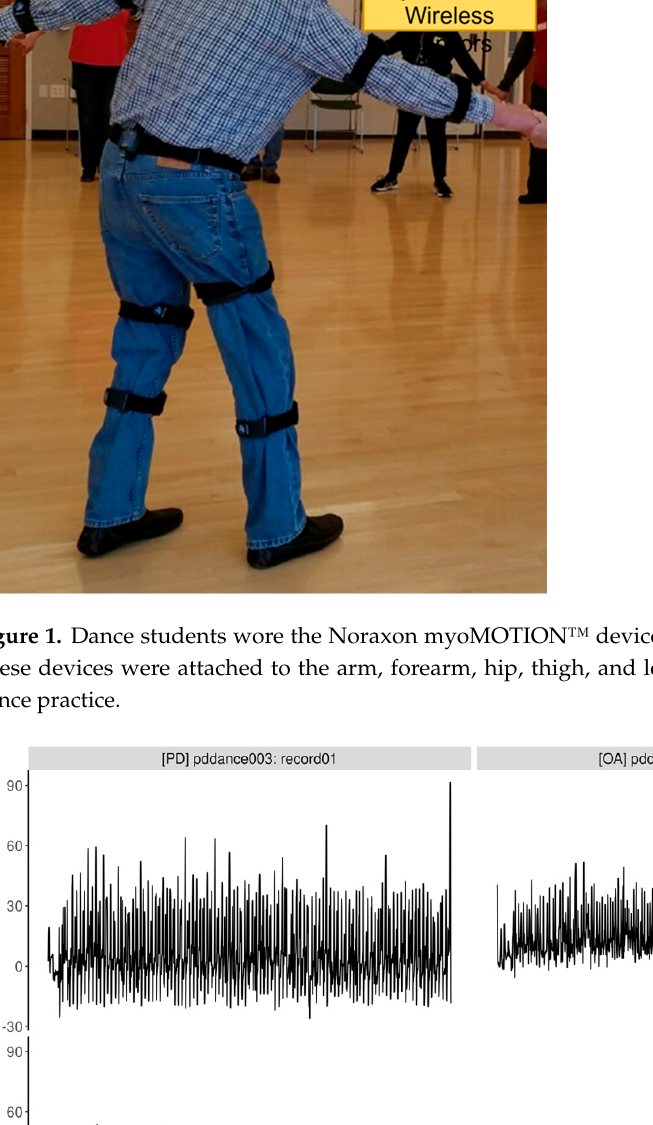
Figure 1. Dance students wore the Noraxon myoMOTION™ devices for a one-hour long session. These devices were attached to the arm, forearm, hip, thigh, and leg, and activated during each dance practice.